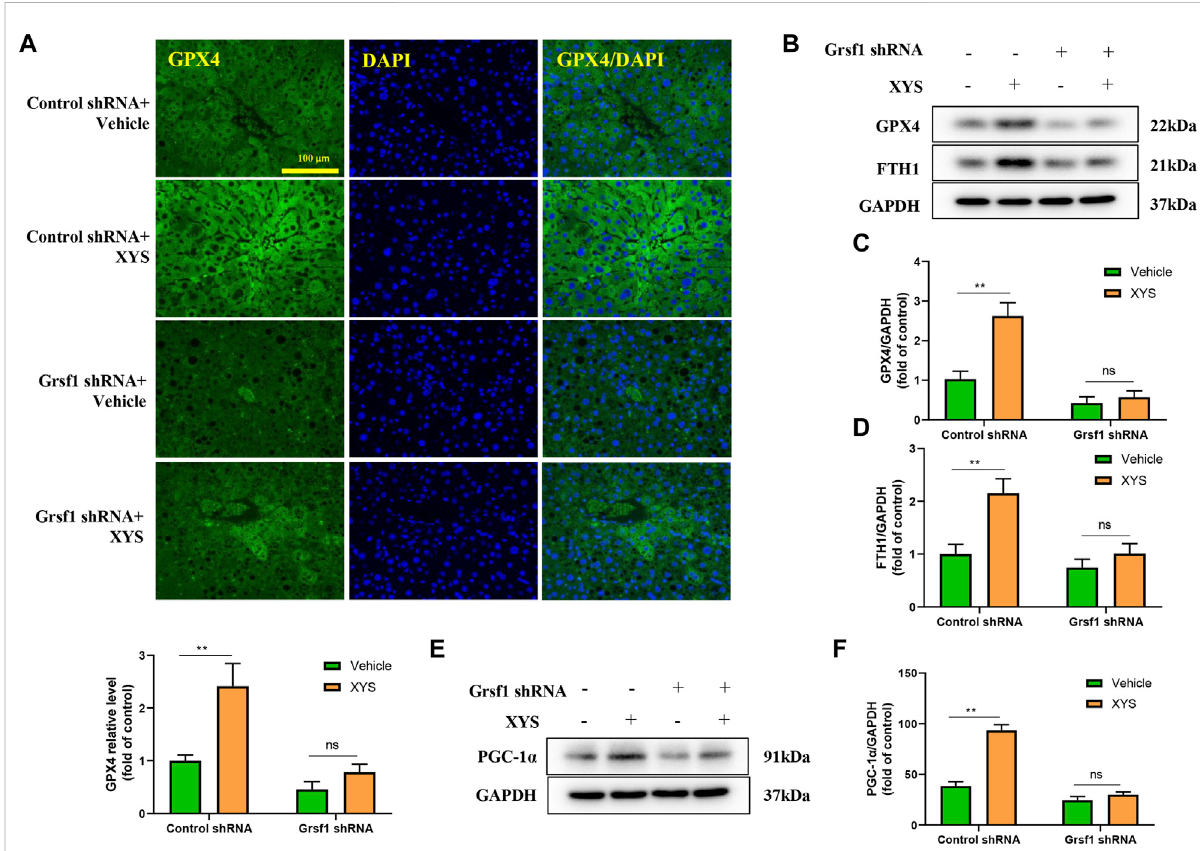
FIGURE 7 The expression of mitochondrial synthesis-related proteins and ferroptosis-related proteins when Grsf1 was inhibited. Control shRNA mice or Grsf1 shRNA mice were treated with or without 0.64 g/kg XYS via gavage for three consecutive days and sacri fi ced on the fourth day. (A) Representative immuno fl uorescent images of GPX4 in liver tissues from each group and relative quantitative histograms of GPX4. Each bar representsthemeanlevelofGPX4inlivertissues±SD. (B – D)